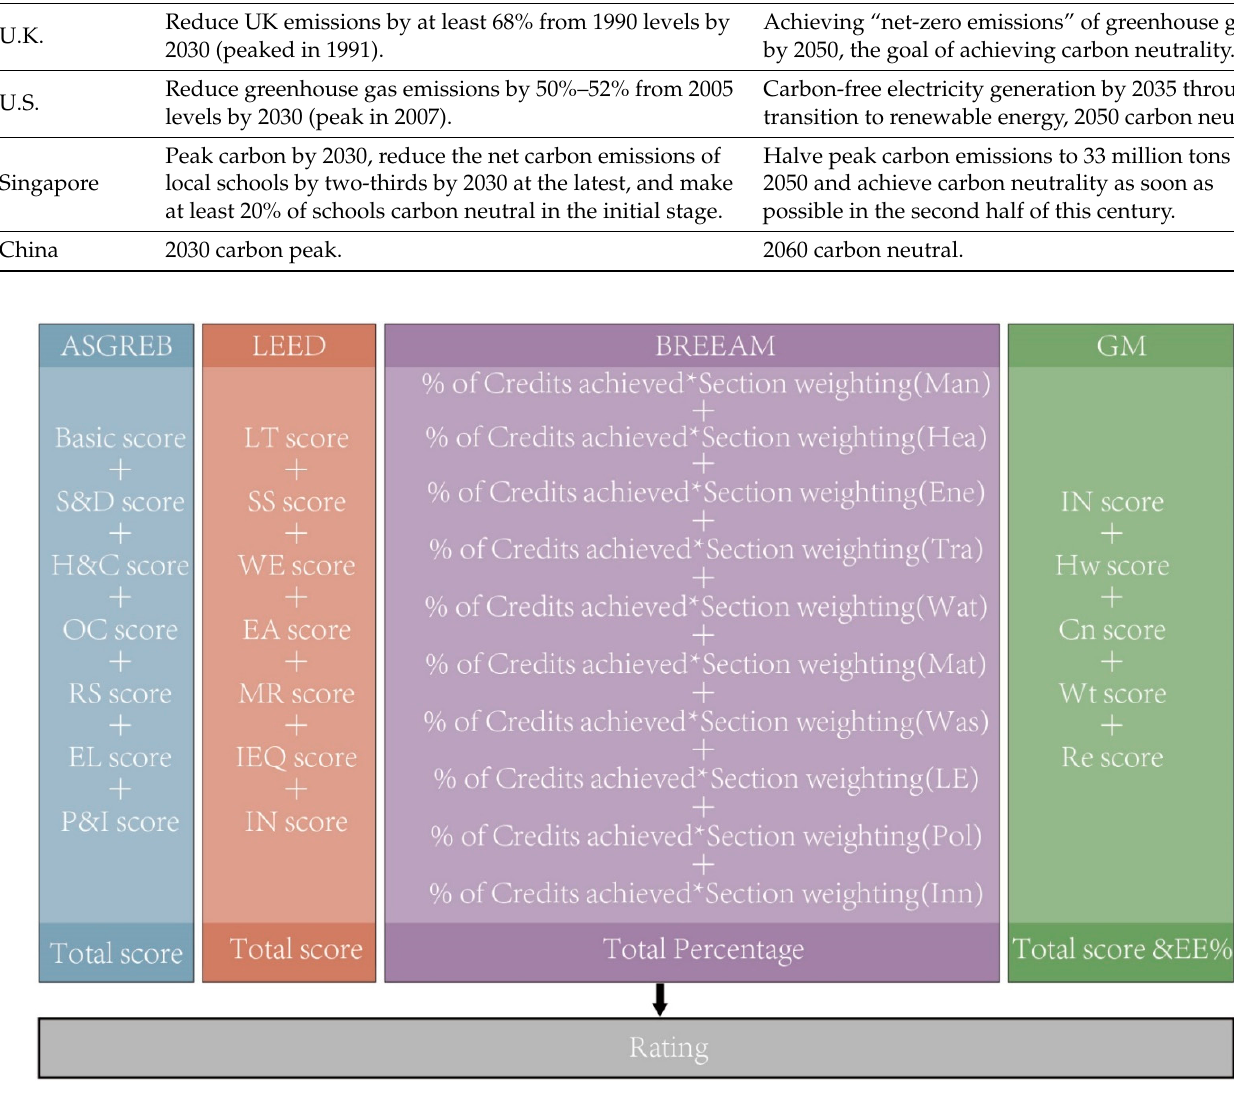
Figure 3. Data treatment method of each GBRS.